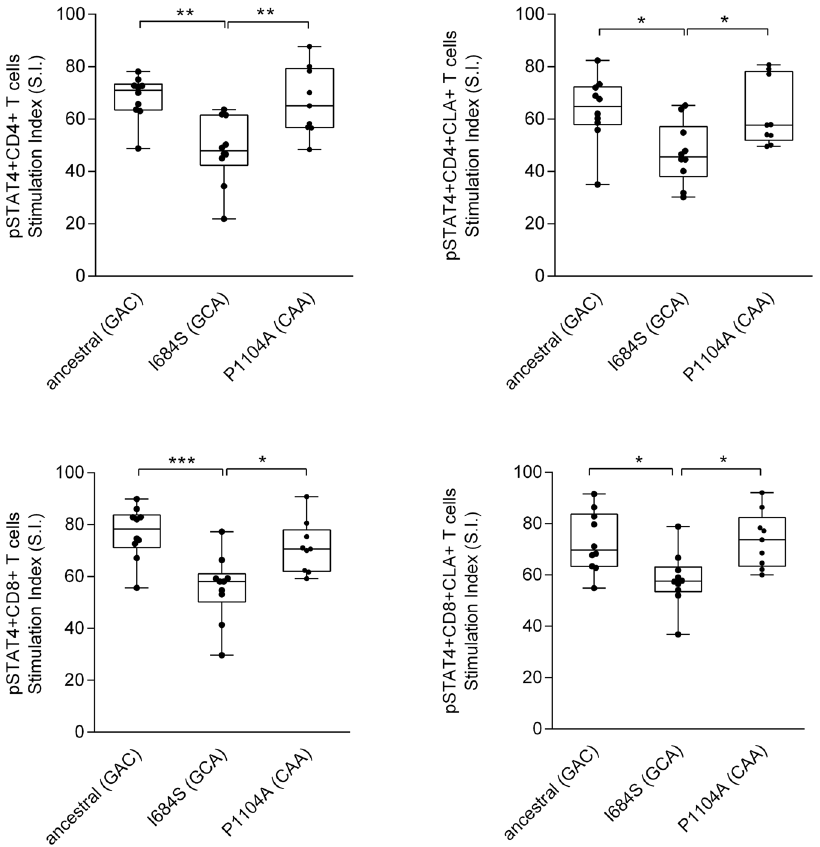
Figure 3. Functional effects of genetic variants in TYK2 on STAT4 phosphorylation in CD4 + and CD8 + T lymphocytes after stimulation with IL-12. PBMCs derived from individuals carrying the ancestral haplotype (n = 10) and from two haplotypes representing the genetic variants I684S (n = 10) and P1104A (n = 9), were cultured for 72 h with anti-CD3/CD28 beads, rested overnight, then stimulated with 50 ng/ ml IL-12 for 1 h and analyzed for intracellular pSTAT4 expression by multicolor flow cytometry. Stimulation Index (S.I.) of pSTAT4 in CD25 + CD45RO + CD4 + and in lymphocyte antigen positive (CLA + ) CD25 + CD45RO + CD4 + T-lymphocytes (upper panel). S.I. of pSTAT4 in CD25 + CD45RO + CD8 and in CLA + CD25 + CD45RO + CD8 T- lymphocytes (lower panel). Box plots: midline indicates median, box extends from 25 th to 75 th percentile, and whiskers indicate minimum to maximum. A p value < 0.05 was considered to be significant. * Indicates p < 0.05, ** indicates p < 0.01, and *** indicates p <